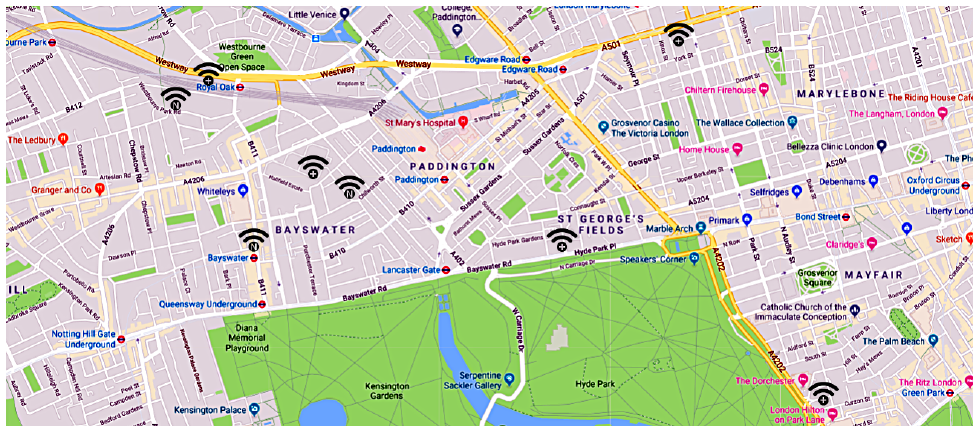
Figure 10. IoE spread